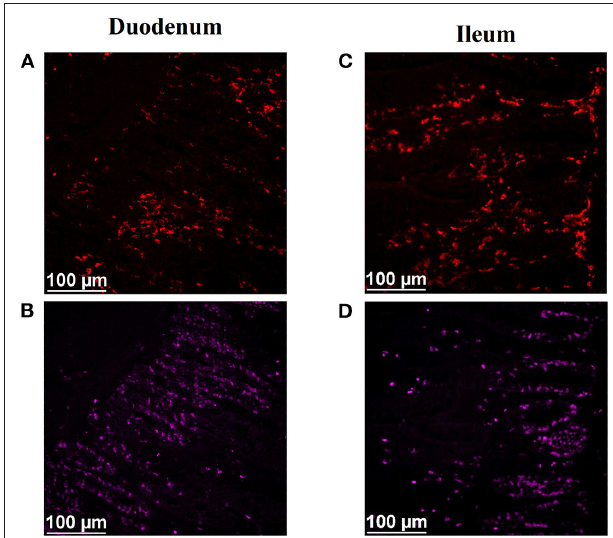
FIGURE 1 | Effect of dietary protein source and litter condition on macrophage (KUL01 + ) and mitotically active (BrdU + ) cell densities (cells per mm 2 ) in the duodenum of 3-d-old broilers ( n = 36 per sampling d, 6 birds per treatment). MBM, meat and bone meal; PFM, 50% poultry by-product and 50% feather meal blend; SBM, soybean meal; NL, new litter; UL, used litter. a,b Bars of the same color representing means from either dietary protein source or litter condition with different superscripts differ at P ≤